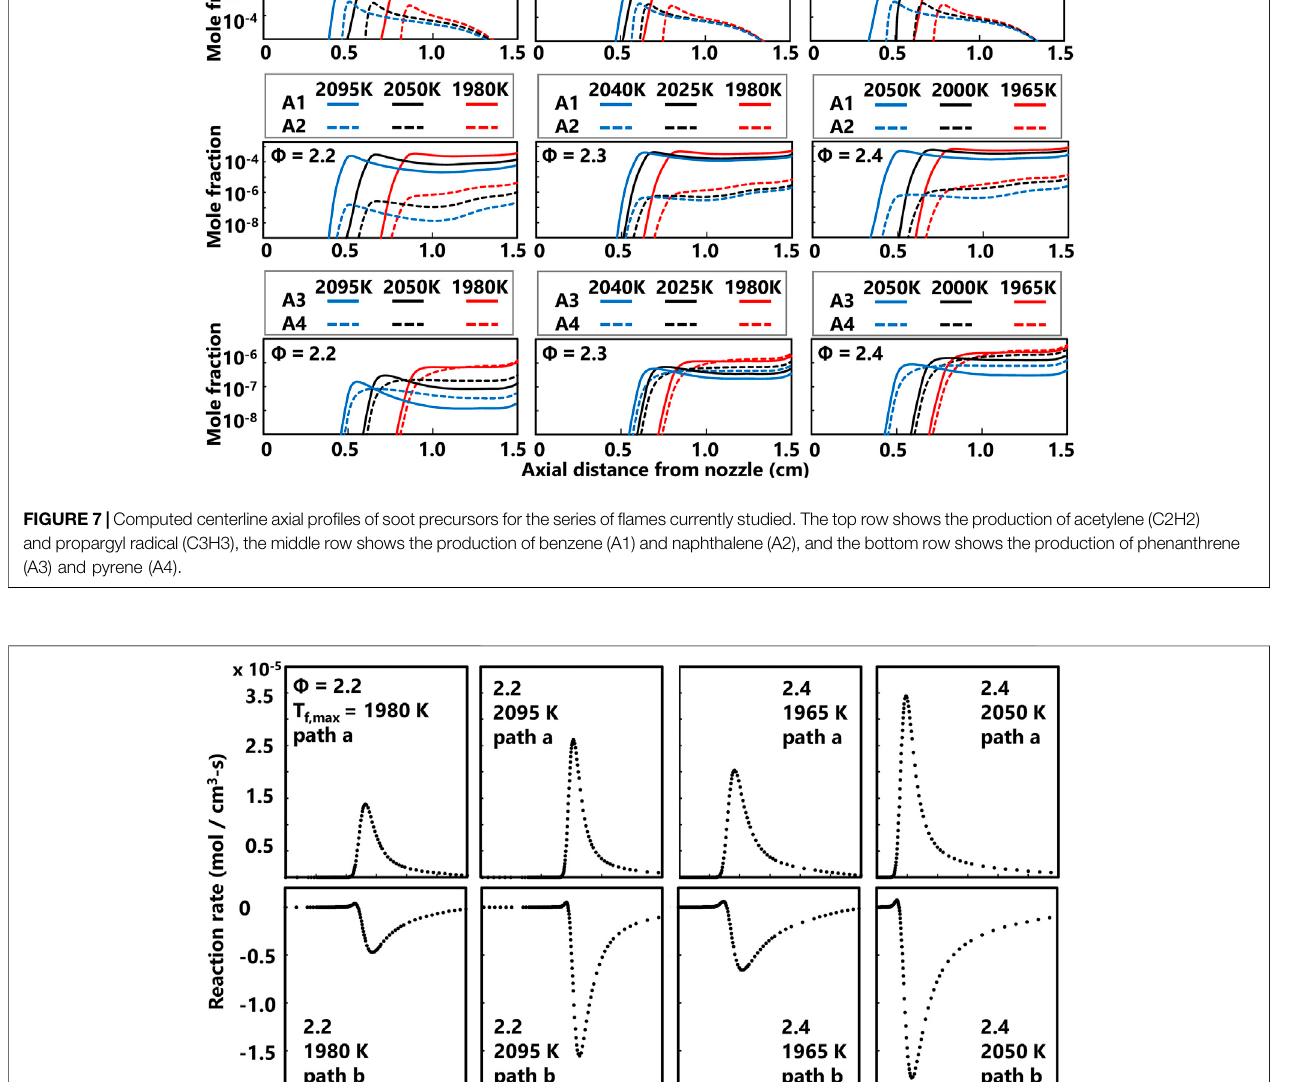
(cid:129) (cid:1) A1 (path a) and the bottom row is the axial pro fi le for the net rate of n-C 4 H 5